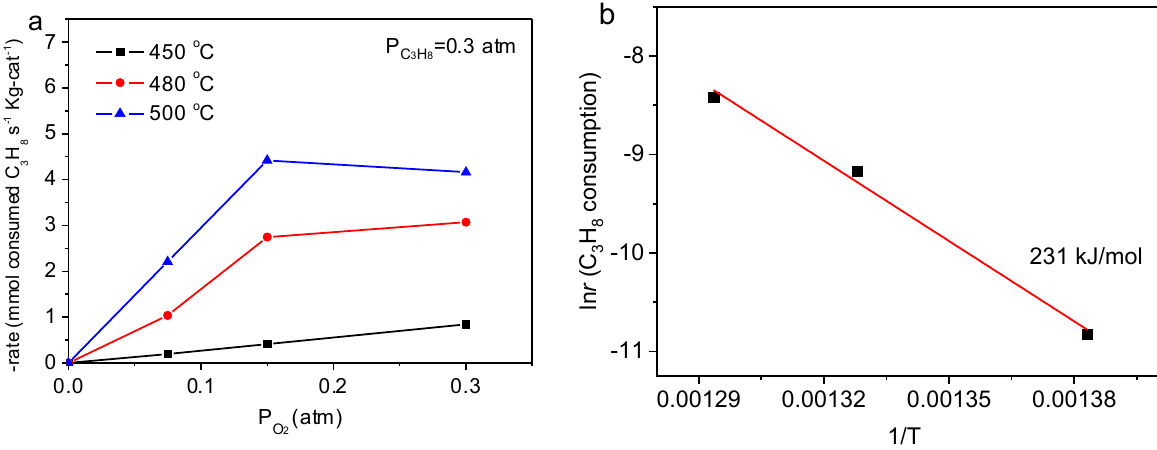
Figure 2. ( a ) Rates of propane consumption as a function of P O2 (P C3H8 constant at 0.3 atm). ( b ) Ar- rhenius plot at 7.5 kPa P O2 . Reaction conditions: various partial pressures of O 2 are 7.5, 15, or 30 kPa,